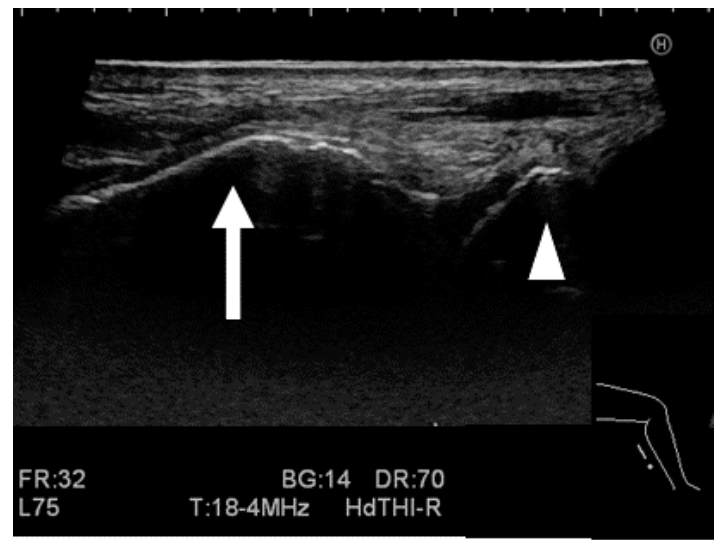
Figure 2. Image of the ultrasound stress imaging test. The arrow represents the edge of the posterior tibial cortical bone, and the arrowhead represents the medial tubercle of the posterior process of the talus.